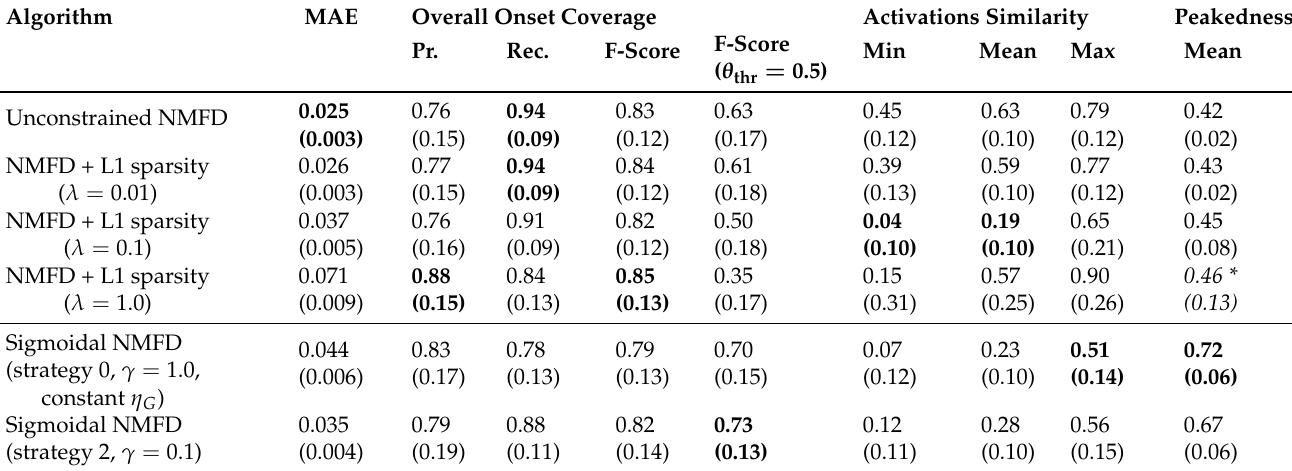
Table 1. Comparison of the performance of the NMFD baseline, the sparse NMFD baselines, and the proposed sigmoidal NMFD model on the evaluation metrics. For each metric, the mean value over all 135 phrases is shown (standard deviation between parentheses). The results for the peakedness metric for the strong sparsity baseline (*) are computed after discarding any all-zero activation curves in H . For each metric, the most optimal value is shown in bold in each